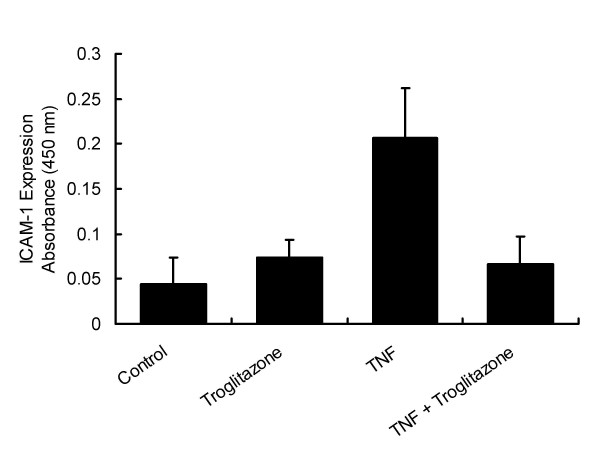
TNF-α induced ICAM-1 protein expression is reduced by troglitazone, a PPAR-γ ligand. TNF-α (1 ng/ml, 24 h) induced ICAM-1 expression was dose dependently blocked by the PPAR-γ ligand, troglitazone at 20 μM (Fig. 4). Alone, this compound had no effect on the expression of ICAM-1 (Fig. 4).